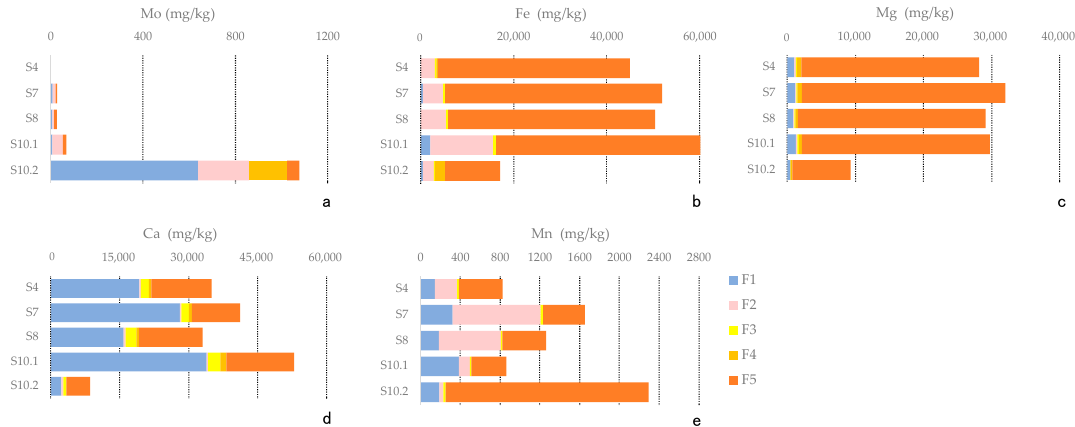
Figure 2. Results of the sequential extraction of river (S4, Erdenet River; S7, Gavil River; and S8, Khangal River) and pond (S10.1 and S10.2) sediment samples for Mo ( a ), Fe ( b ), Mg ( c ), Ca ( d ), and Mn ( e ).